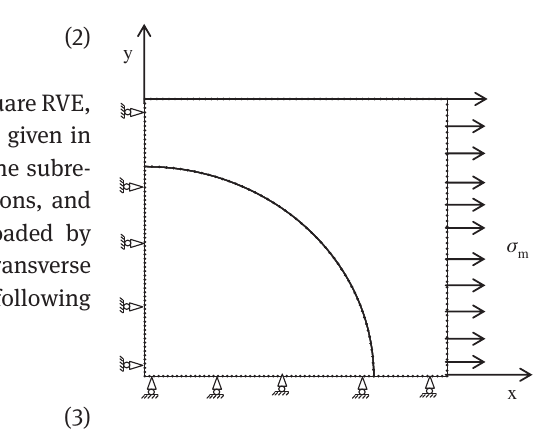
Figure 2 BIE model